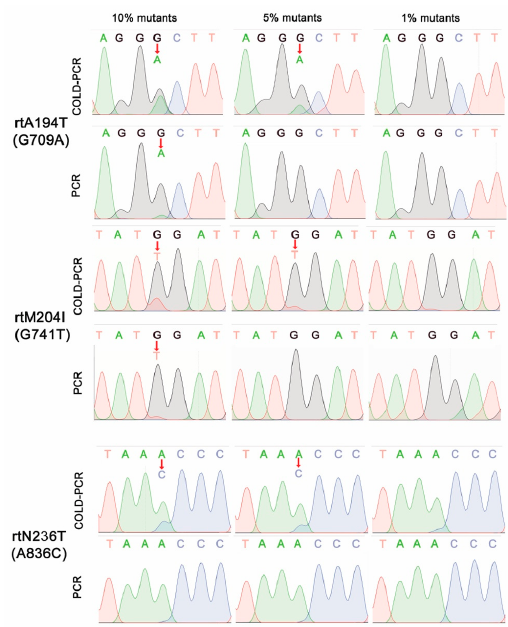
Figure 3. Conventional PCR and COLD-PCR evaluations for 1%, 5%, and 10% mt abundance following dilution of plasmids carrying rtA194T (G709T) mt in domain B, rtM204I (G741T) mt in domain C, and rtN236T (A836C) mt in domain D of HBV RT into the wt plasmid: the red arrows are positions of mutated bases in the DNA sequencing chromatograms.